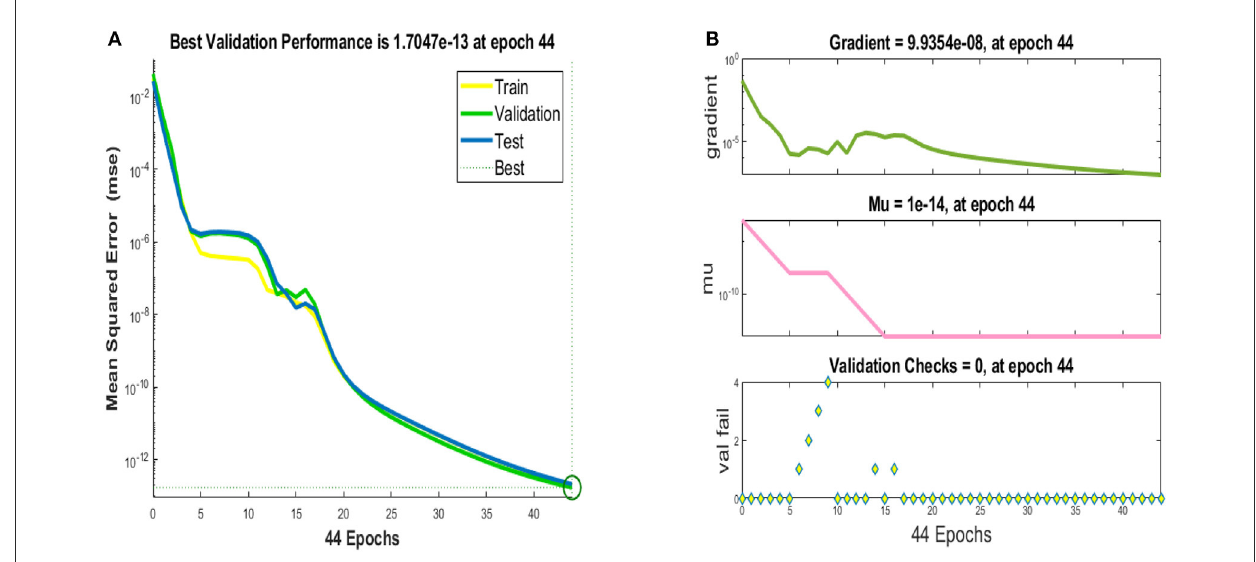
FIGURE5 MSE and STs performances for the HBV system. (A) MSE: Case 2. (B) EHs: Case 2.